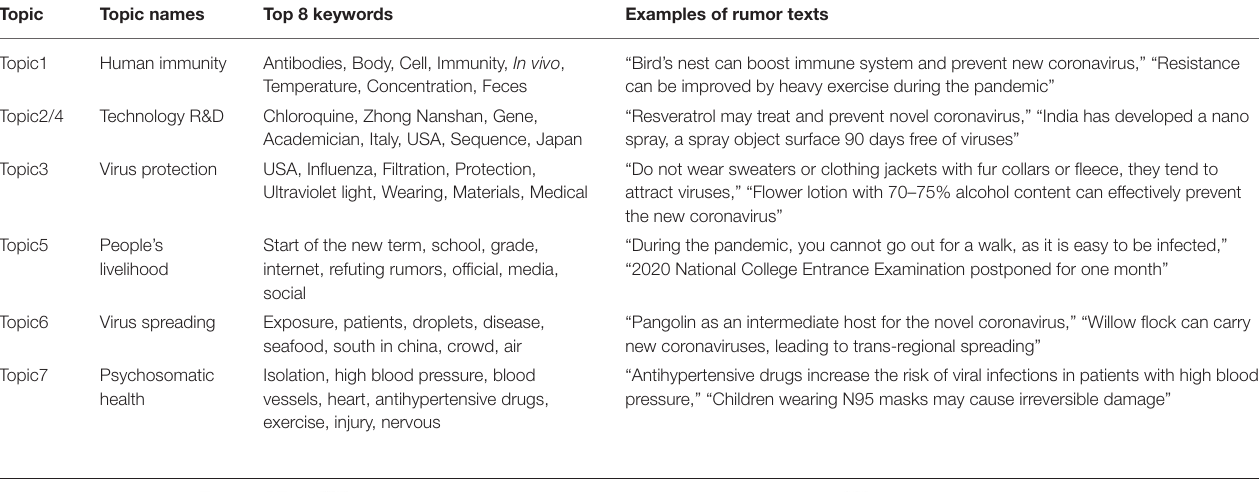
TABLE 1 | Extracted topics, keywords and examples of rumor texts.